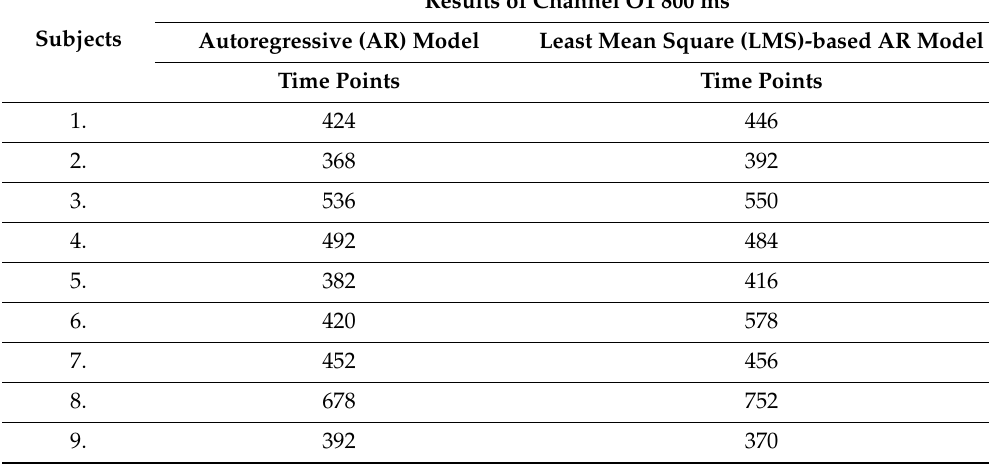
Table 1. Time points crossing the significant Rayleigh’s PLV for channel O1 for both the autoregressive (AR) model and the least mean square (LMS)-based AR model. Asterisk (*) means that out of 800 ms, the particular channel did not cross the significant value ( >